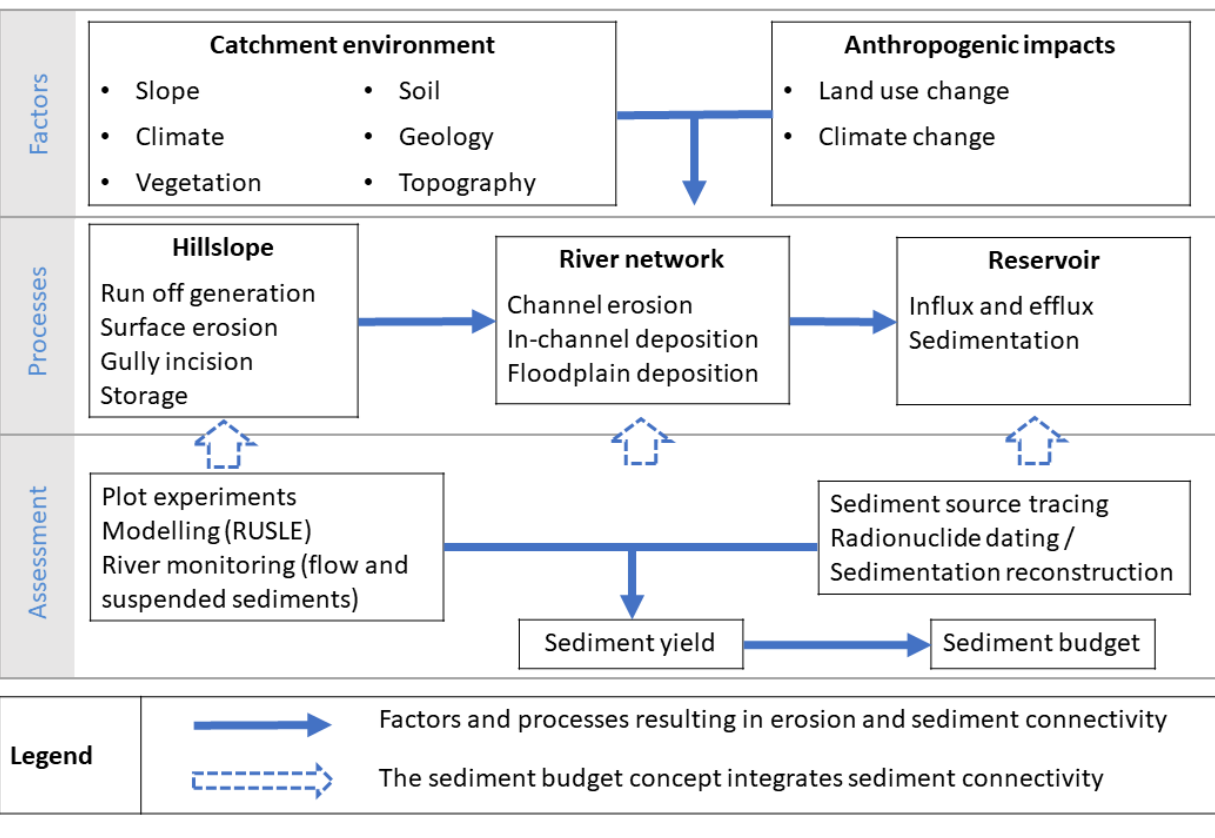
Figure 1. Sediment delivery in the complex catchment and the sediment budget processes.